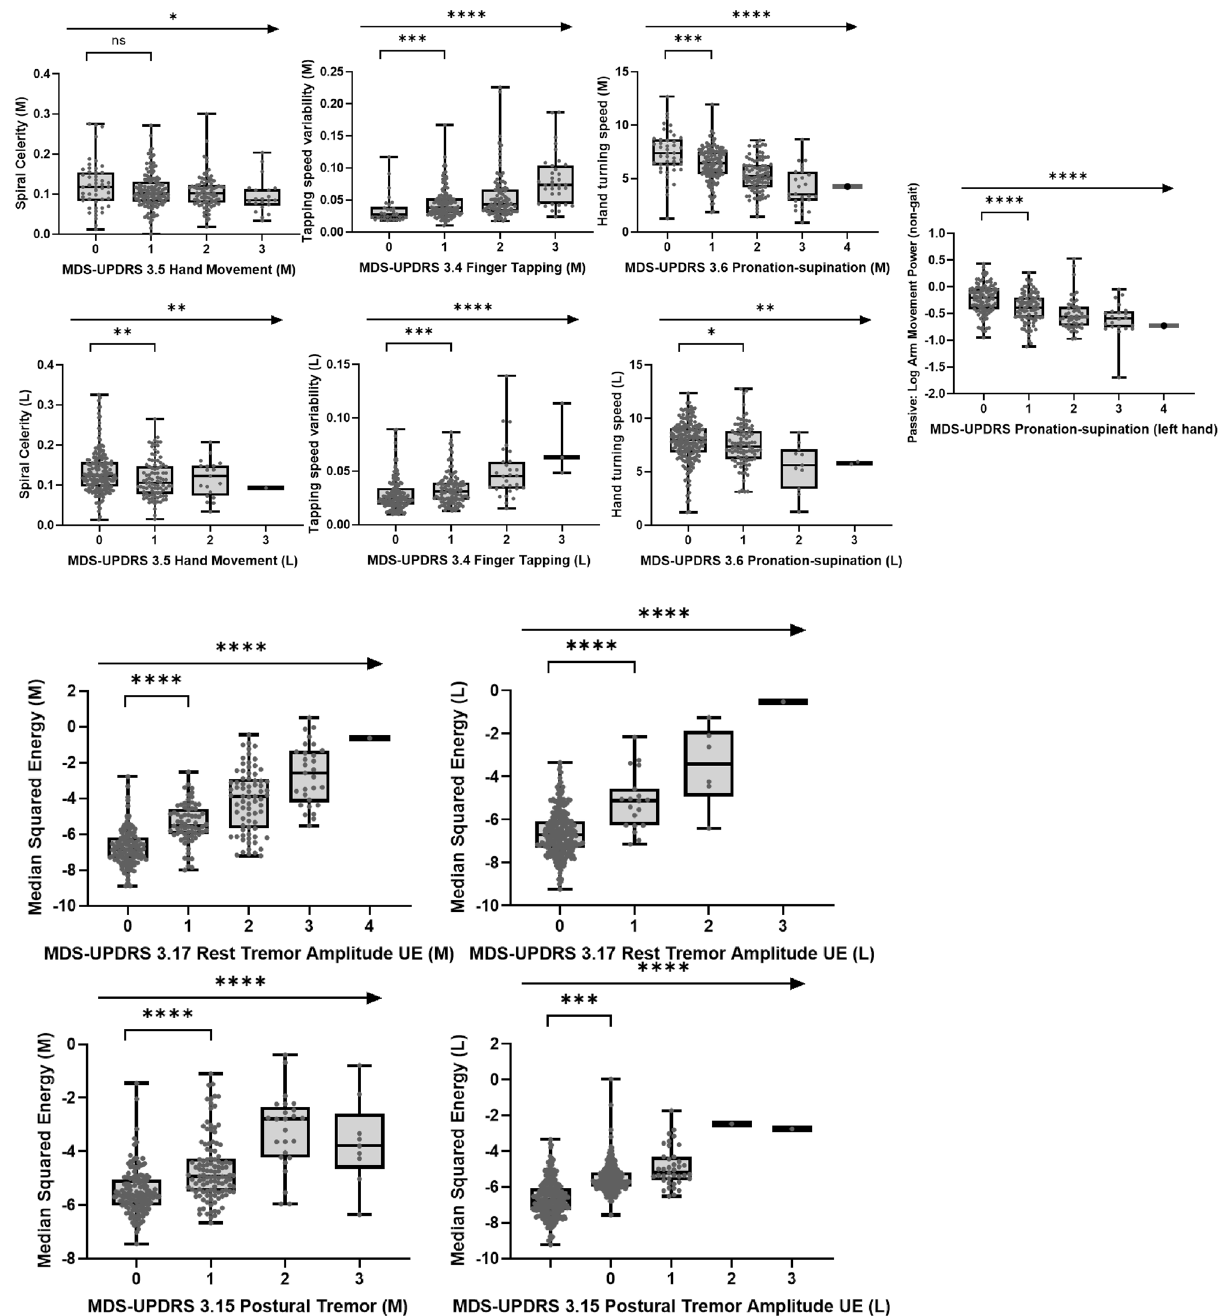
Figure 3. Association of sensor features from upper limb bradykinesia tests and upper limb tremor tests with corresponding clinical MDS-UPDRS measures at baseline (ns = P > 0.05; * = P ≤ 0.05; ** = P ≤ 0.01; *** = P ≤ 0.001; **** = P ≤ 0.0001). L less affected side, M more affected side, MDS-UPDRS Movement Disorder Society—Unified Parkinson’s Disease Rating Scale, UE Upper